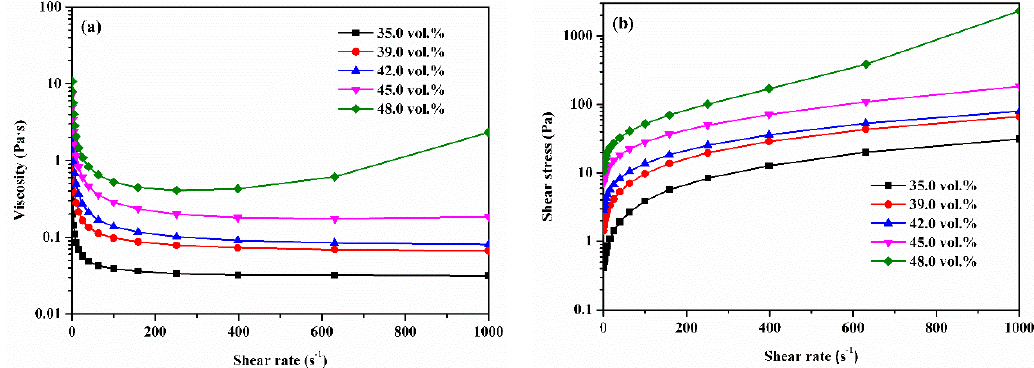
Figure 3. ( a ) Viscosities and ( b ) shear stress of KNN suspensions with different solid loadings.